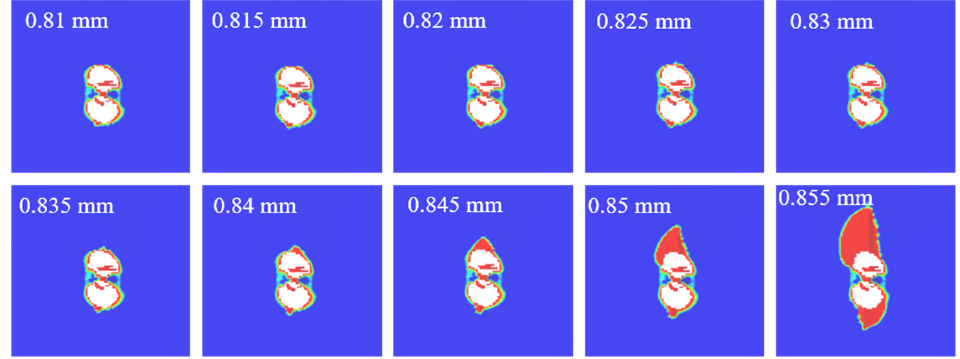
Figure 10. Delamination propagation with different compressive displacements.